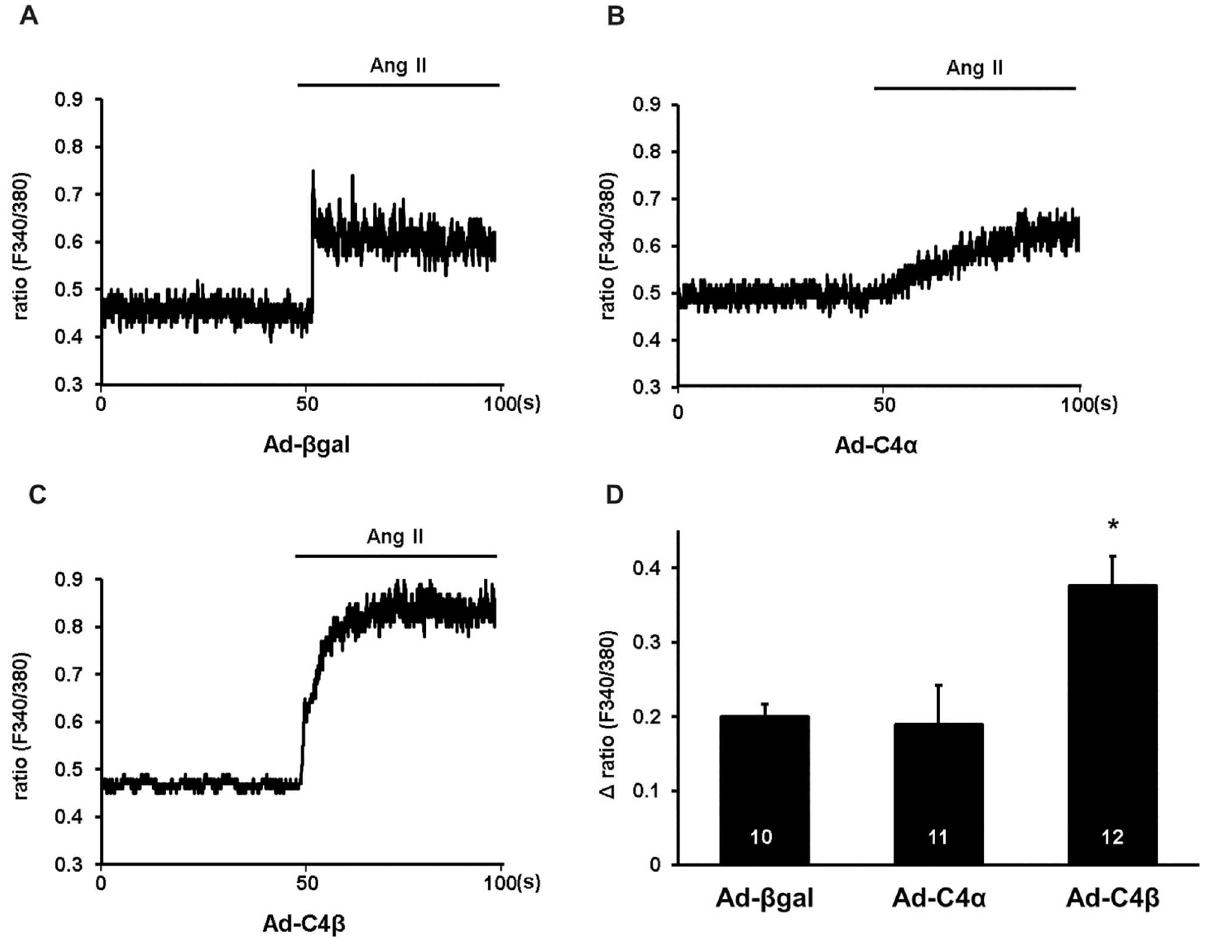
Fig 3. TRPC4 β overexpression is connected with an increased Ca 2+ influx after angiotensin II stimulation of cardiomyocytes. A, Representative Fura-2 Ca 2+ traces in neonatalrat cardiomyocytes (NRCs) infected with either Ad- β gal(A), Ad-TRPC4 α (B) or Ad-TRPC4 β (C). Quiescent cells were perfused with a normal Tyrode solution containing 1 mM Ca 2+ . Verapamil (10 μ M) was includedthroughoutthe recordings.After 50 s, angiotensin II (Ang II; 1 μ M) was applied.D, Mean Δ ratio values were calculatedby subtractingthe peak value after Ang II additionfrom the baselinevalue. * P < 0.05vs Ad- β galand Ad-TRPC4 α . Cells from three different experiments were analyzed.N- number of cells is indicatedin the